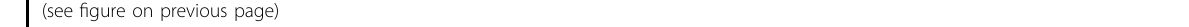
Fig. 4 NFIL3 negatively regulates Treg signature genes. The promoter activity of each gene was measured using a transient reporter assay. a EL4 cells were transfected with each promoter-luciferase construct and control or N fi l3 -expressing vectors. b EL4 cells were transfected as described in a , with the addition of cotransfection of a Foxp3 -expressing vector. The relative luciferase activity was calculated by dividing fi re fl y luciferase activity by Renilla luciferase activity. Icos , Tnfrsf18 (GITR), Ctla4 , and Il2ra (CD25) mRNA and protein expression levels were measured in control and N fi l3 - overexpressing Treg cells by qRT-PCR ( c ) and fl ow cytometry ( d ). e pSTAT5 levels in control (empty) or N fi l3 -overexpressing Treg cells were measured by fl ow cytometry. The mean fl uorescence intensity (MFI) for each experiment was measured and pooled from three independent experiments ( d, e , right panel). Transient reporter assay data are pooled from three independent experiments. qRT-PCR and dot plot data are representative of three individual experiments. Error bars represent the SD. The signi fi cance of differences between groups was determined by Student ’ s t test. * P < 0.05, ** P < 0.01, *** P < 0.001, and **** P < 0.0001, n.s. not signi fi